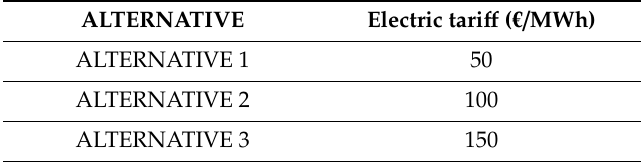
Table 5. Alternatives based on the electric tari ff considered ( € / MWh).